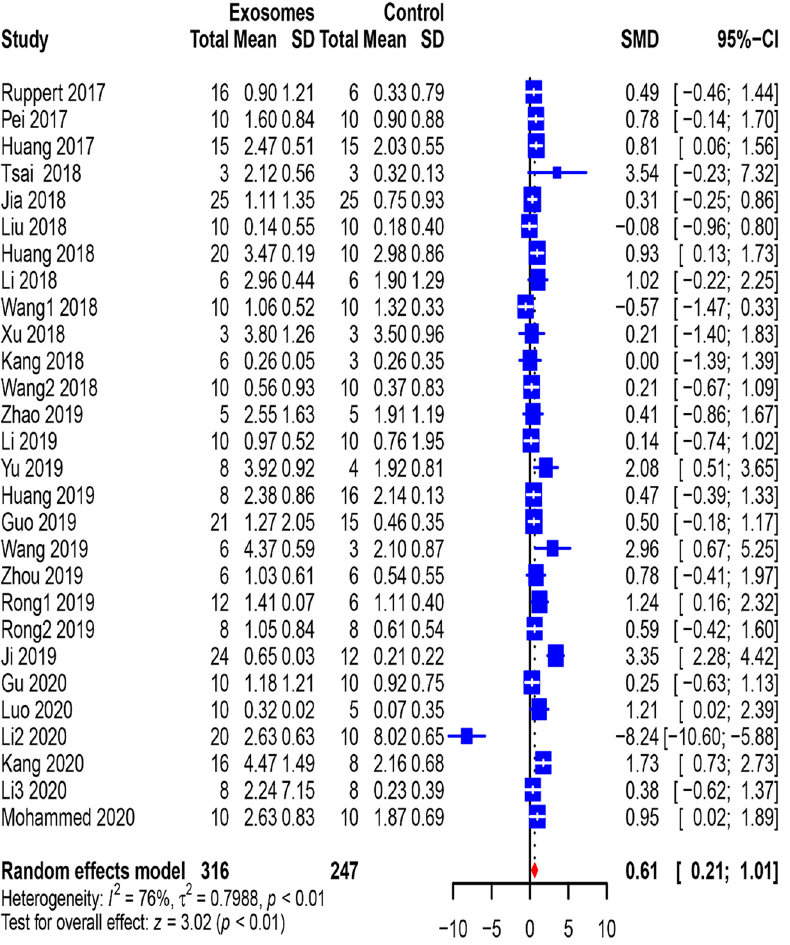
Figure 2: Pooled - analysis of Basso, Beattie, and Bresnahan scale at the fi rst measurement after SCI. SCI, spinal cord injury; SMD, standard mean di ff erence; SD, standard di ff erence; CI, con fi dential